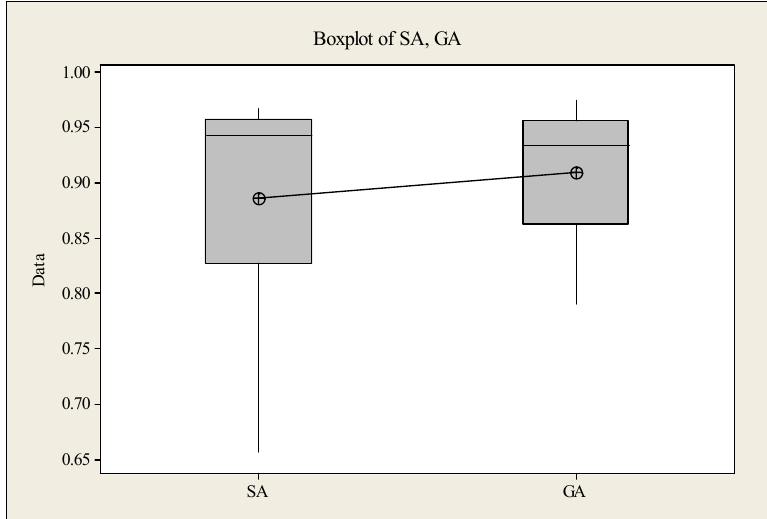
Fig. 5. Comparison of the performance in terms of runtime